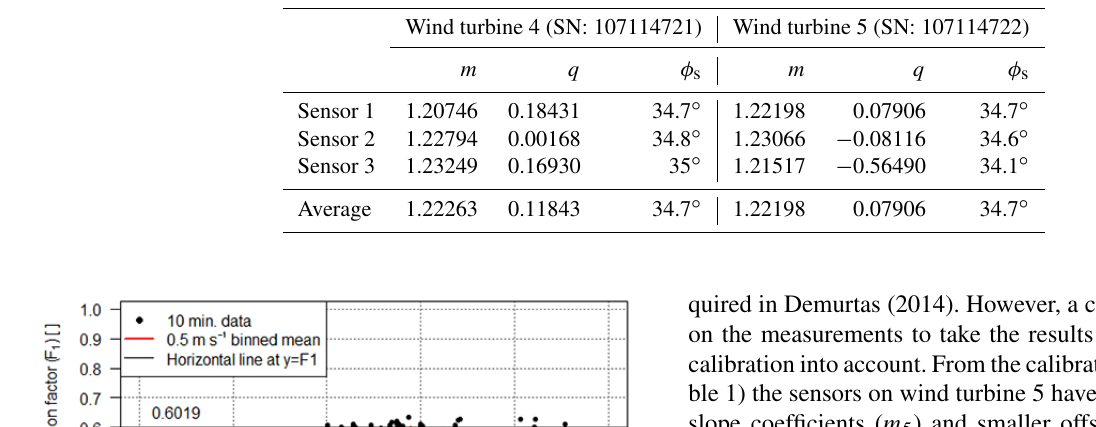
Table 1. Sensor path angle ( φ s ), slope ( m ) and offset ( q ) coefficients of the sonic sensor wind tunnel calibrations.